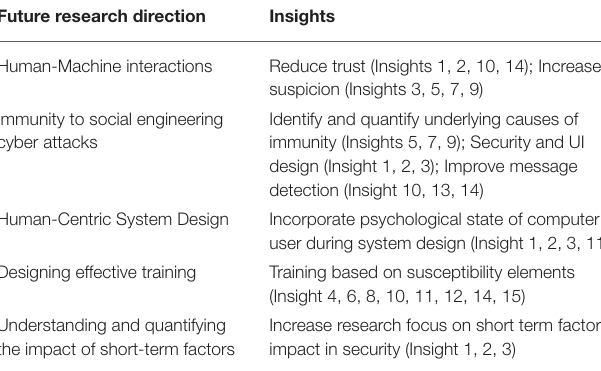
TABLE 3 | Relationships between future research directions and